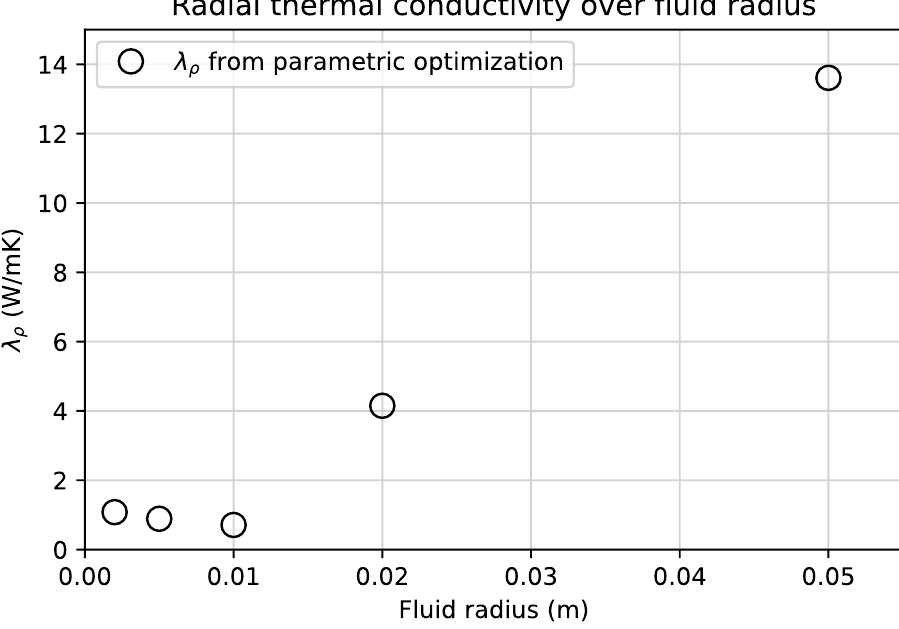
Figure 10. Resulting λ ρ from the optimization over the fluid radius r inner